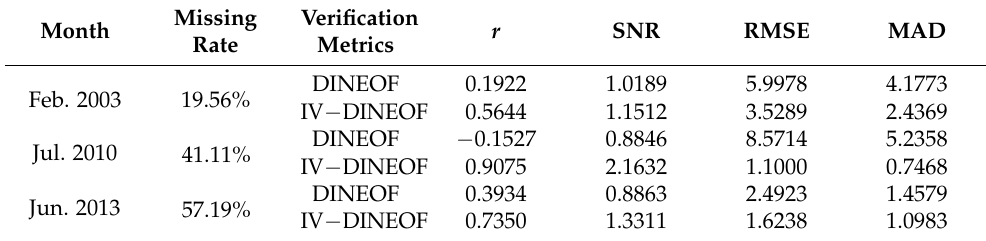
Table 4. Comparison of verification metrics of reconstruction results between DINEOF and IV − DINEOF with different single-month missing rates using